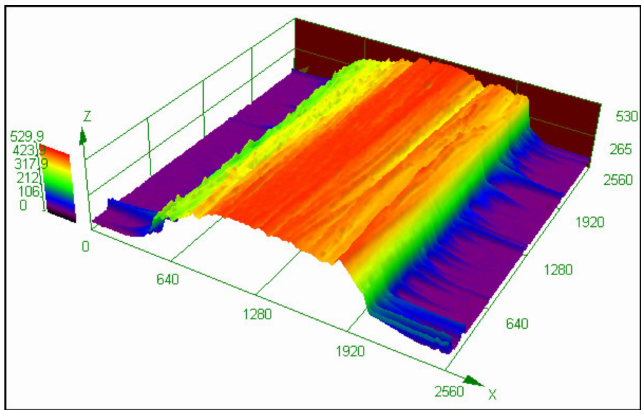
Figure 9. 3D profile of the printed fiber bundle with a width of 1.8 mm and a thickness of 0.4 mm.